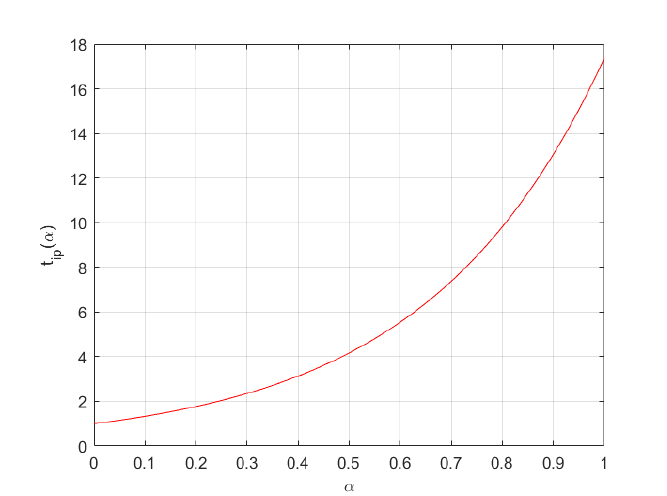
Figure 5. The inflection point as function of α by choosing z ( 0 ) = 3, r K = 100, r (cid:48)